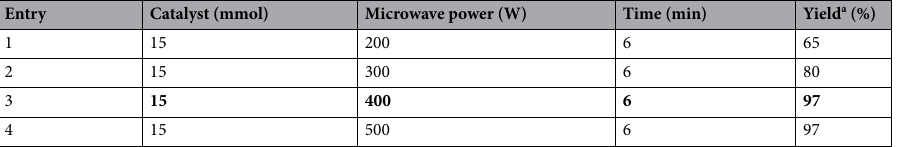
Table 3. Effect of microwave power on the synthesis of trial reaction. Reaction conditions: 1a (1 mmol), 2 (3 mmol), 3 (1 mmol), and catalyst (15 mmol) in water (2 mL). Significant values are in bold. a Isolated yield.